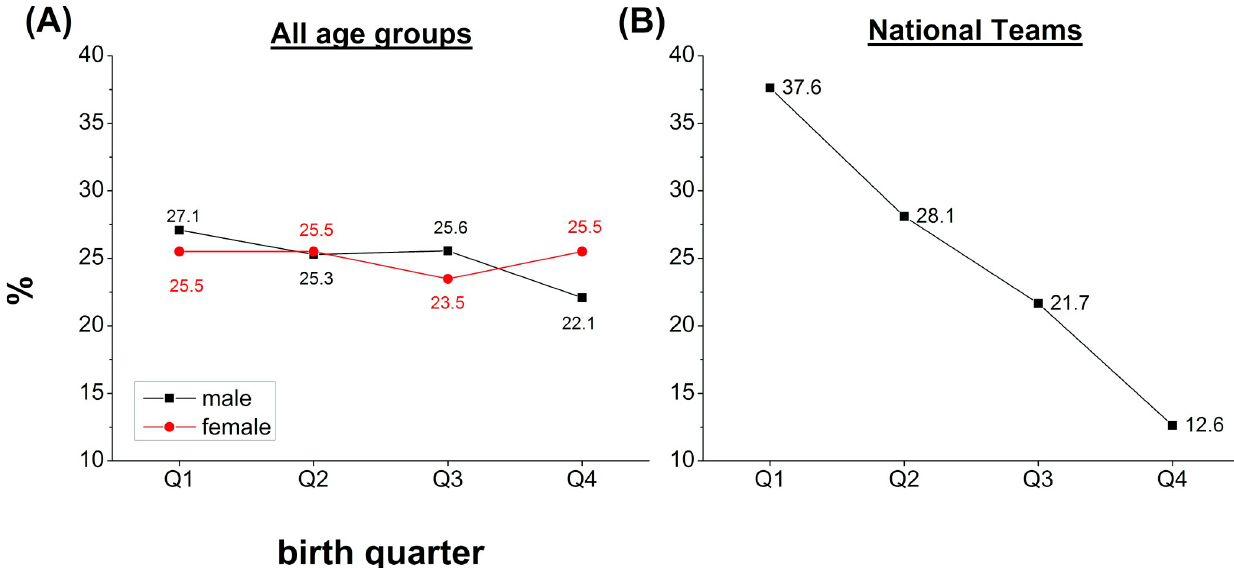
Fig 1. Male and female player distribution across age groups. (A) Distribution of male (black) and female (red) players in the whole population of Luxembourgish football players. (B) Player distribution across birth quarters in the Luxembourgish national teams. Data points reflect average values across age groups.